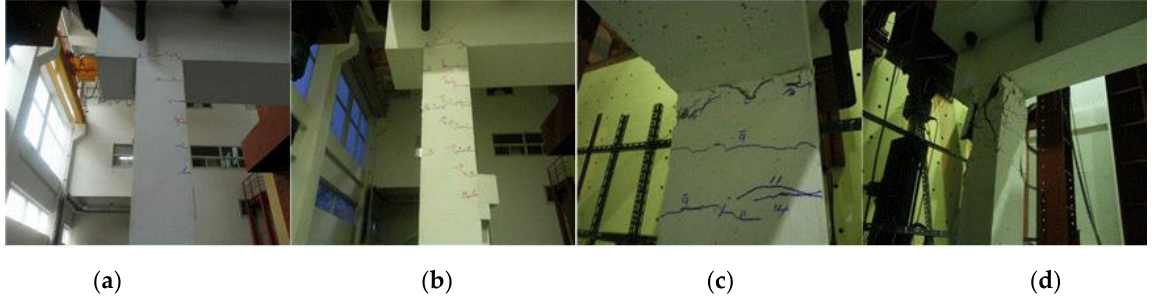
Figure 16. Failure sequence of the RC frame without the WKDS (upper-left corner). ( a ) 8 Cycle (0.40%), ( b ) 12 Cycle (1.00%), ( c ) 14 Cycle (1.56%), ( d ) final.